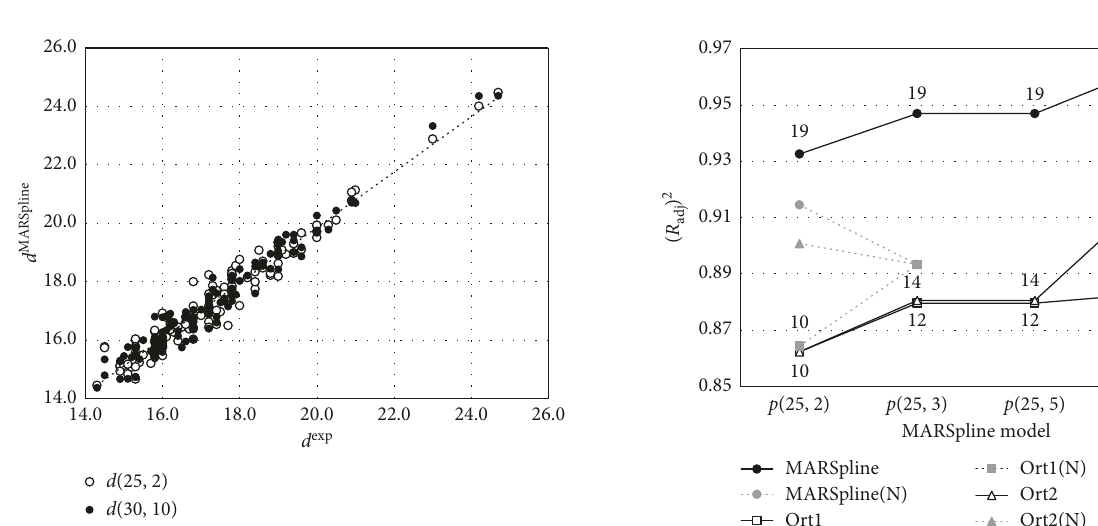
Figure 2: The correlation between experimental and computed values of parameter d prediction is done using Eq. (1). The quality of the chosen optimal d (25, 2) model is characterized by the fitting criteria: R 2 � 0.9470, ( R adj ) 2 � 0.9378, LOF � 0.3680, K xx � 0.4341, RMSE tr � 0.4293, MAE tr � 0.3239, F � 103.3872, and N � 130, and fulfils the following internal validation criteria: ( Q loo ) 2 � 0.8601, RMSE cv � 0.6973, and MAE cv � 0.4309 [71, 72].